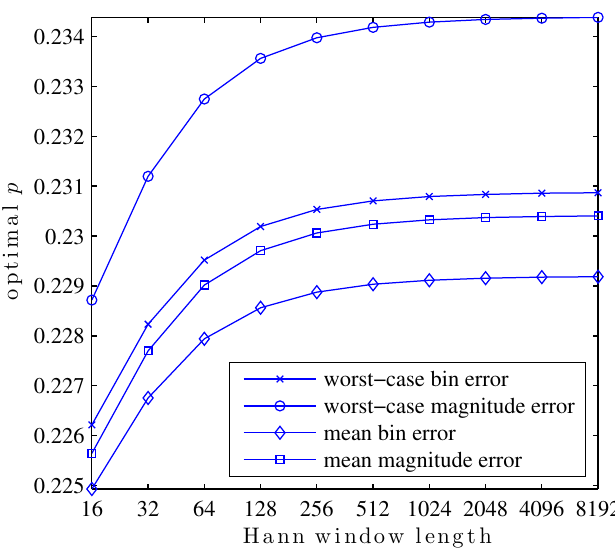
[ | e K ( K ) | ] , E [ | e X ( K ) | ] ) for different e w.c. K , X , E